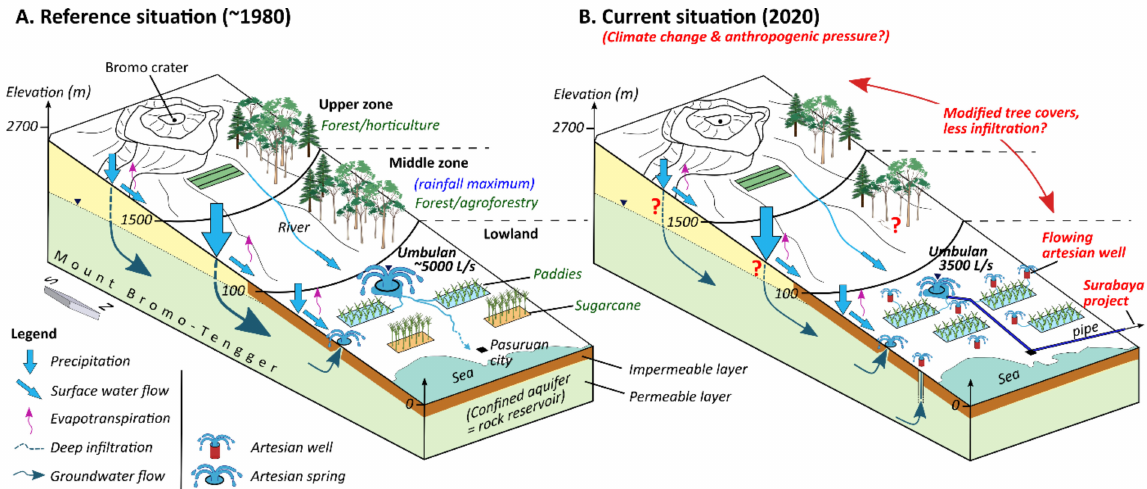
Figure 1. The simplified block diagram of the landscape and zone-specific water balance, illustrating ( A ): the historical reference scheme 1980, and ( B ): the current situation in